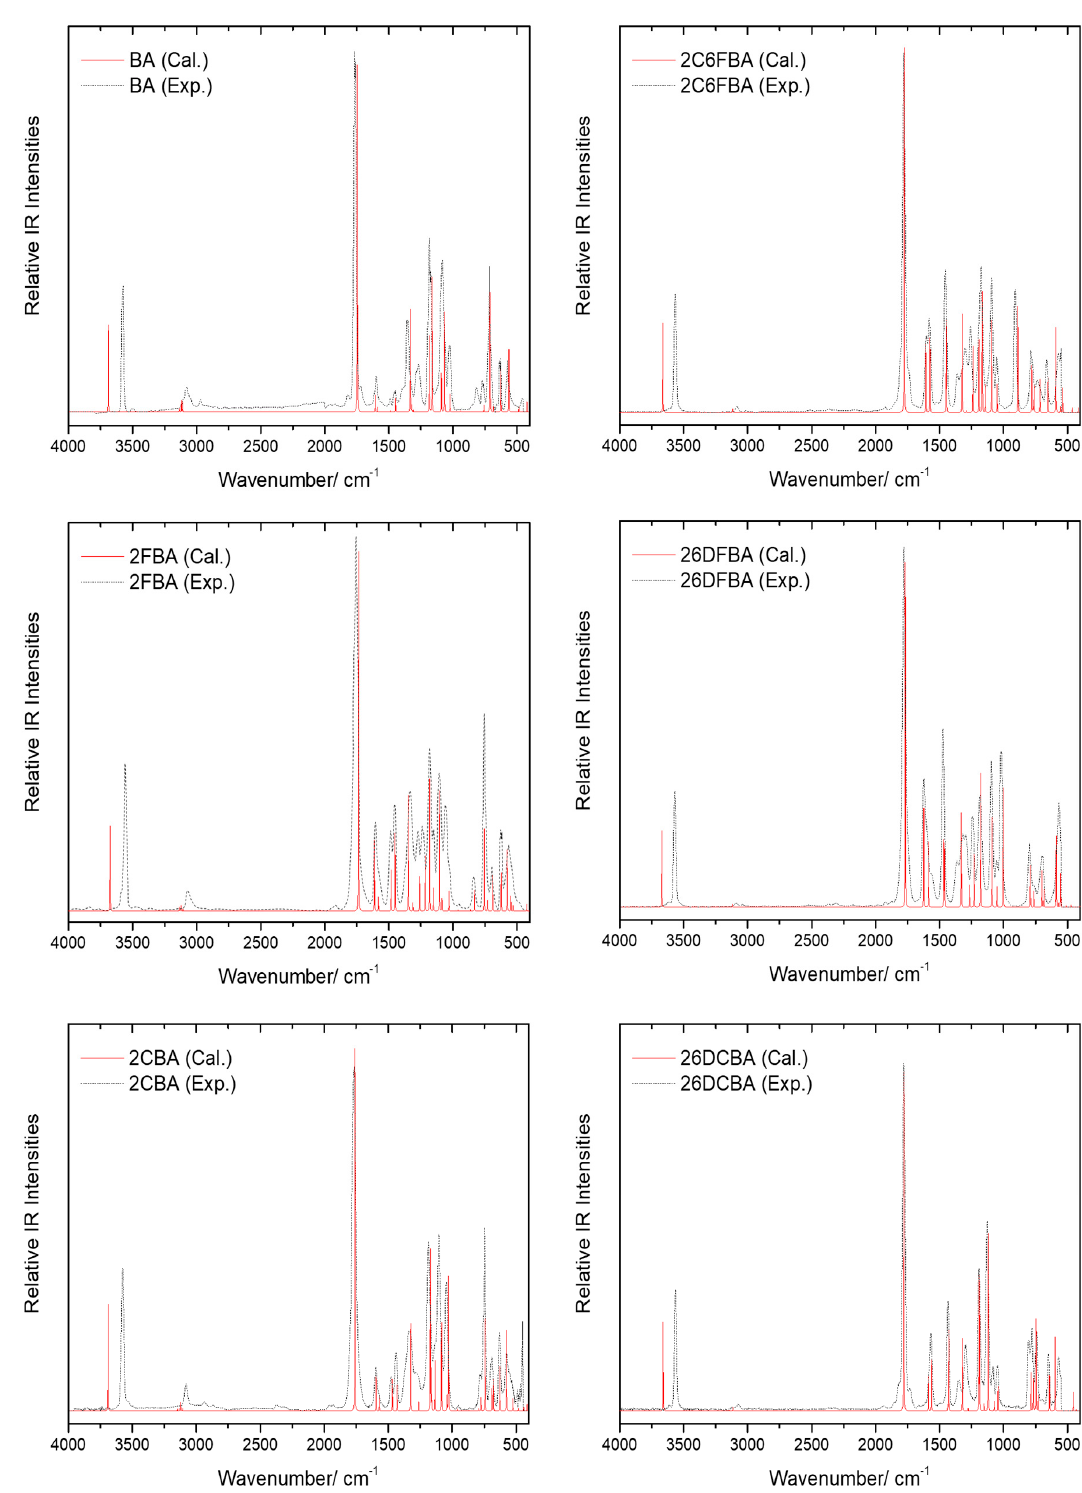
Figure 13. Gas phase infrared spectra of the studied compounds (black dashed traces) and B3LYP/6- 311++G(d,p) calculated infrared spectra for their experimentally relevant conformers (red traces), in the 4000–450 cm –1 region. Calculated frequencies are scaled by 0.978. For simplicity, only the calculated spectra for the most stable conformers of 2FBA ( cis -II) and 2CBA ( cis -I) are shown in the figure (see also text).